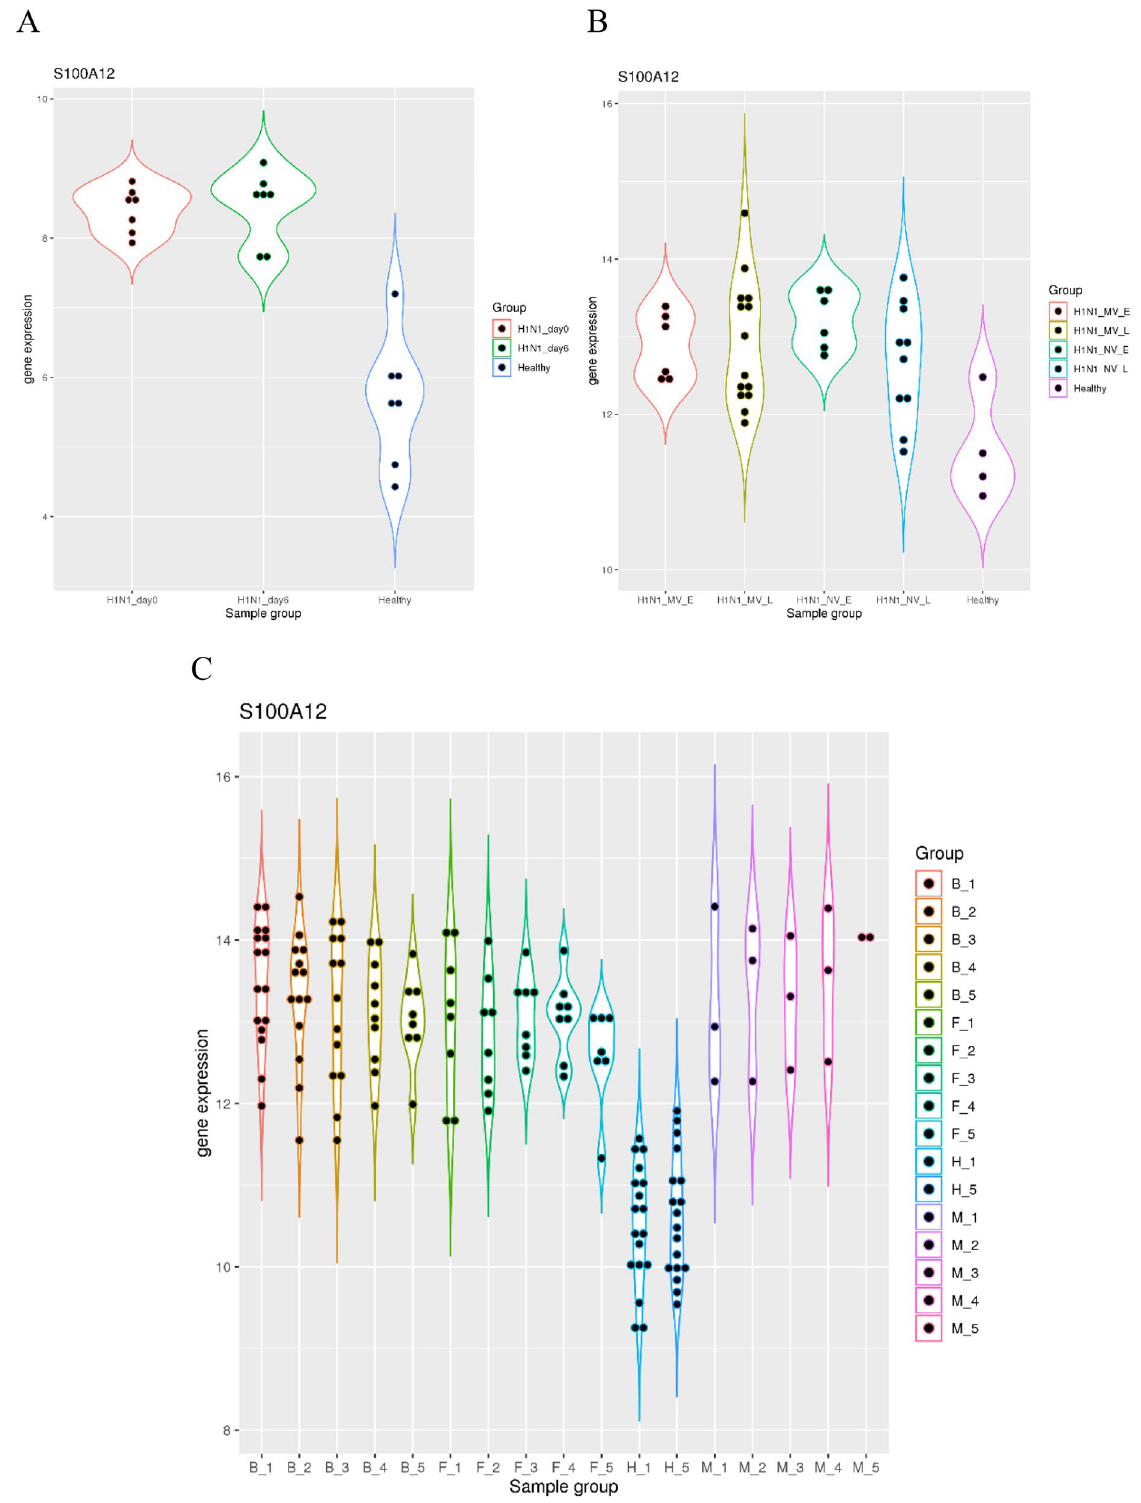
Figure 2. S100A12 as a marker for the severe influenza infection. ( A ) upper left, comparison of S100A12 expression in healthy controls and patients with severe H1N1 infection at two time points. ( B ) upper right, comparison of S100A12 expression in healthy controls and patients with severe H1N1 infection at two time points (early and late course of the infection). Patients with severe H1N1 infection were further divided into two groups (with or without mechanical ventilation). ( C ) lower panel, comparison of S100A12 expression in healthy controls and patients with severe bacterial pneumonia, severe influenza pneumonia and severe pneumonia with mixed infection at five time